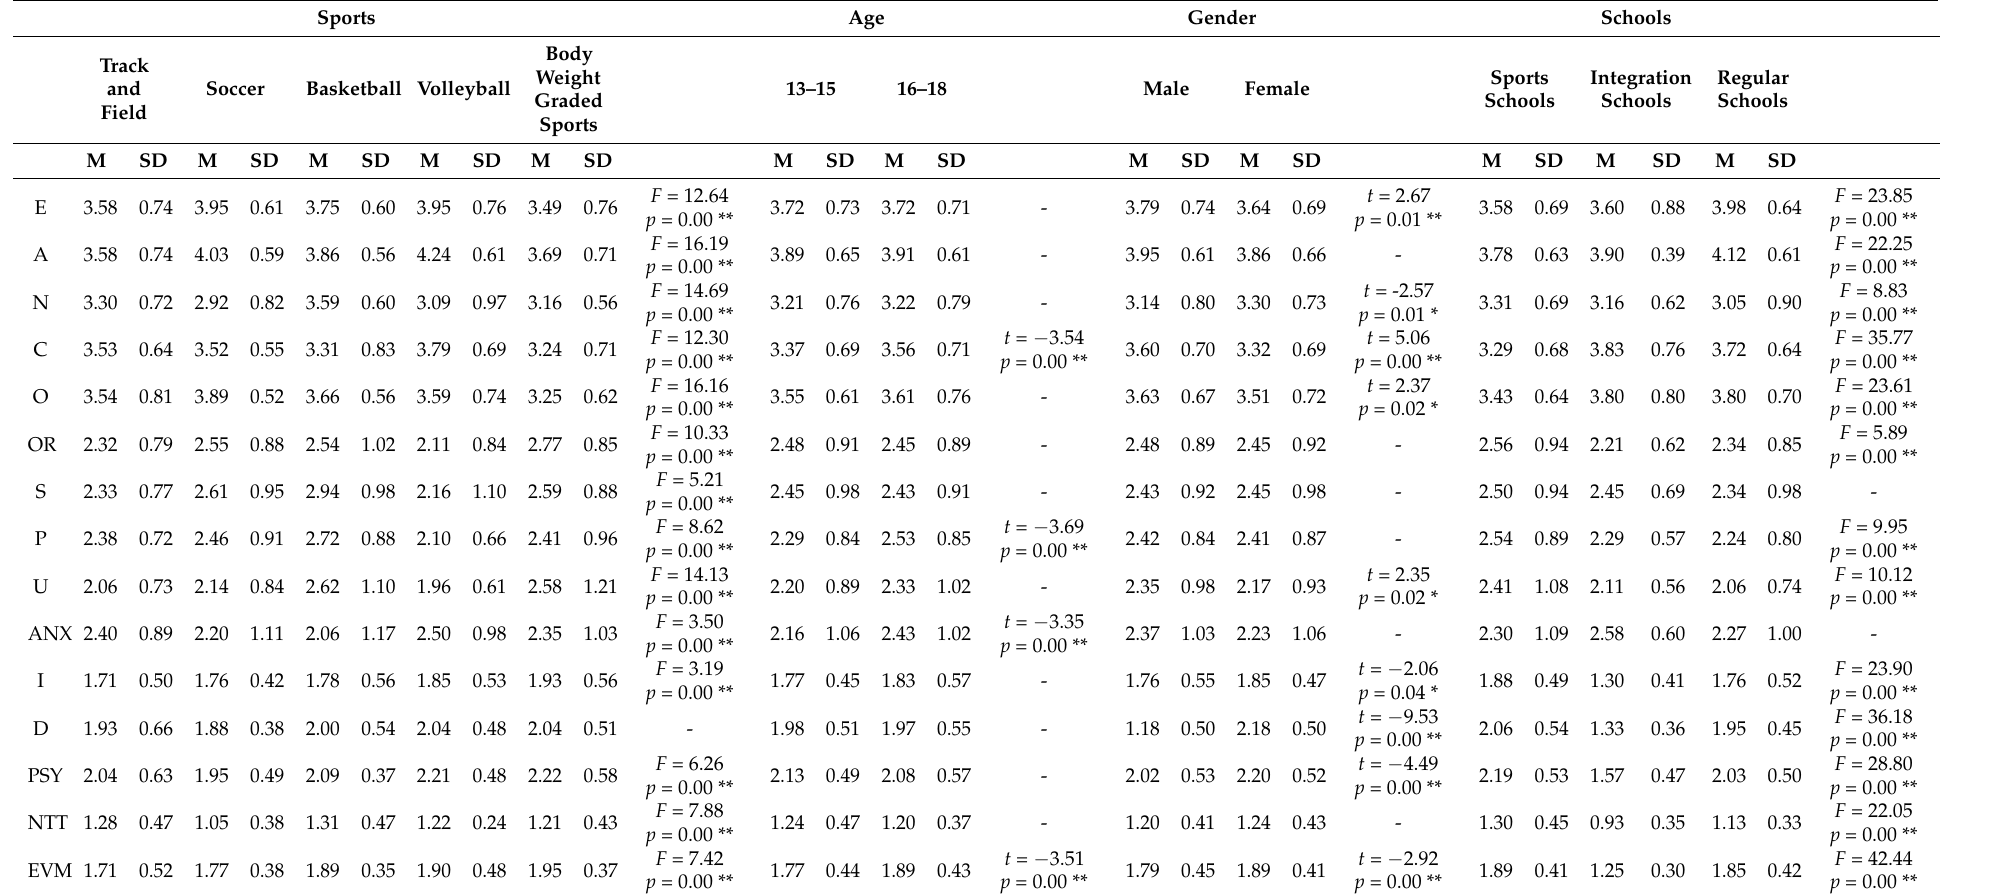
Table 3. The differences of all included variables among sports, age, gender, and schools ( n = 664). Sports Age Gender Schools Track